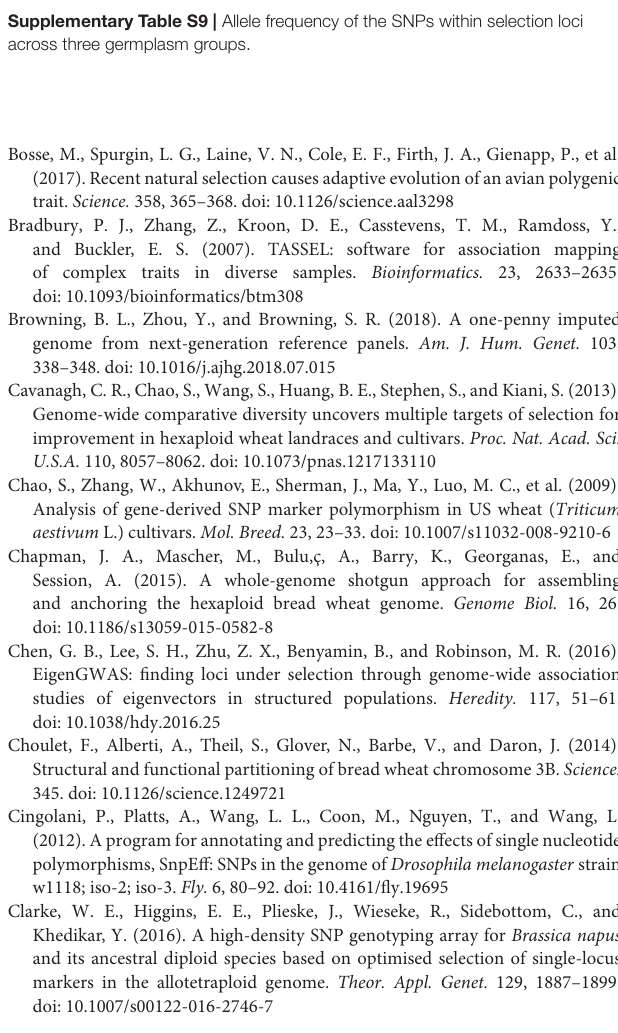
Supplementary Table S2 | The averaged genetic diversity parameters across chromosomes and genomes for each subpopulation (a–c). The SYN-DER indicates synthetic-derived wheats; PC, commercially released Pakistan cultivars; AL, advanced breeding lines. Supplementary Table S3 | The nucleotide diversity (pi) and Tajima’D summary statistics in the whole population (WP), synthetic-derived wheats (SYN-DER), commercially released Pakistan cultivars (PC), and advanced breeding lines. Supplementary Table S4 | The relative kinship between pairs of 422 accessions computed from 18,589 GBS-SNPs. The SD indicates synthetic-derived wheats; PC, commercially released Pakistan cultivars; AL, advanced breeding lines. Supplementary Table S5 | Rogers’ genetic distance among pairs of 422 accessions calculated from 18,589 GBS-SNPs. The SD indicates synthetic-derived wheats; PC, commercially released Pakistan cultivars; AL, advanced breeding lines. Supplementary Table S6 | The average r 2 values of each pairwise SNPs for each chromosome and genome. The SYN-DER indicates synthetic-derived wheats; PC, commercially released Pakistan cultivars; AL, advanced breeding lines. Supplementary Table S7 | Summary statistics from EigenGWAS analysis for 422 wheat